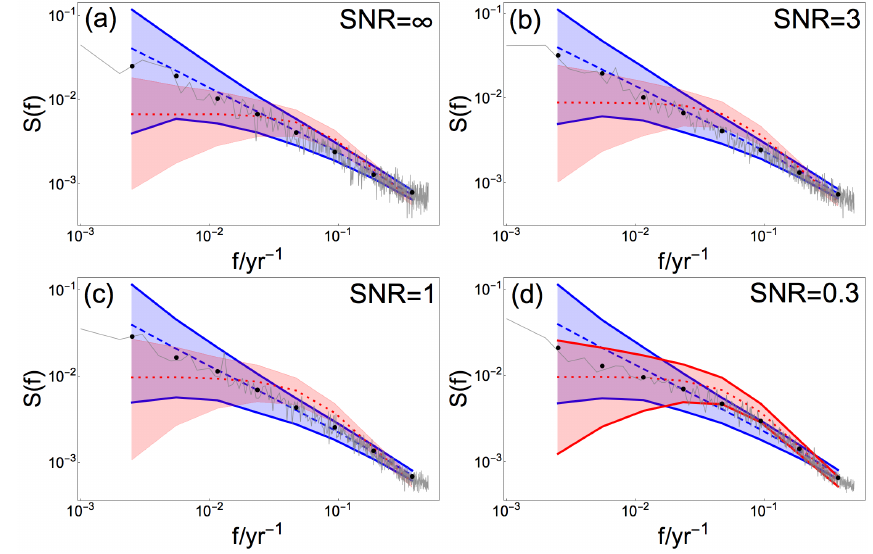
Figure 5. Mean raw and log-binned PSD for the spatial mean reconstruction (gray curve and dots, respectively), generated from β target = 0.75 and different SNR indicated in (a) – (d) . Colored shading and dashed/dotted lines indicate 95% confidence range and the ensemble mean, respectively, for a Monte Carlo ensemble of fGn with β = 0.75 (blue) and of AR(1) processes with α estimated from BARCAST (red). The confidence ranges found consistent with the data are drawn with solid lines.